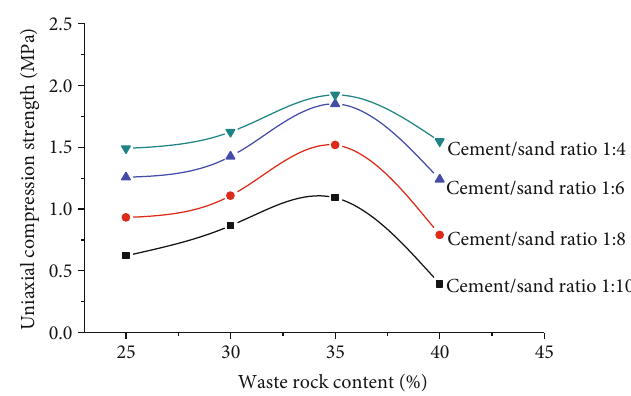
Figure 4: Uniaxial compressive strength under di ff erent waste rock contents.